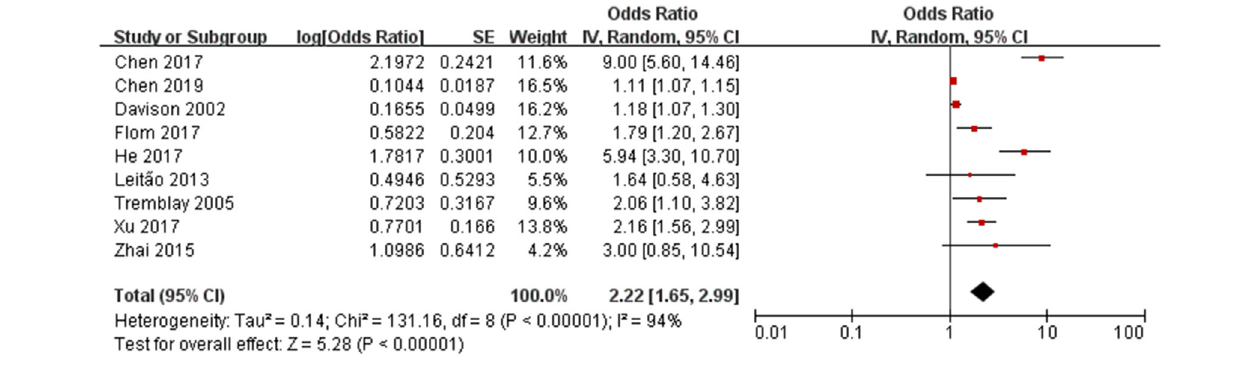
FIGURE 2 | Forest plot of childhood overweight/obesity and the risk of early puberty in girls.